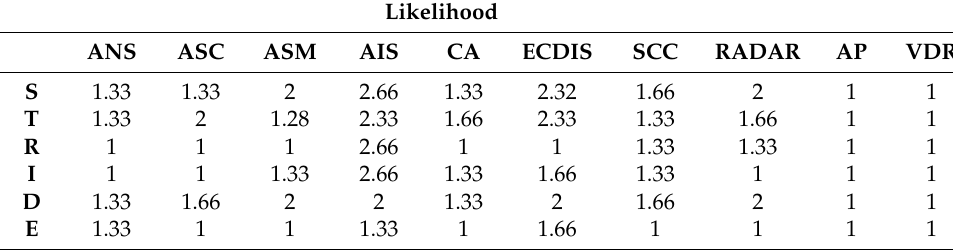
Table 3. Likelihood values.